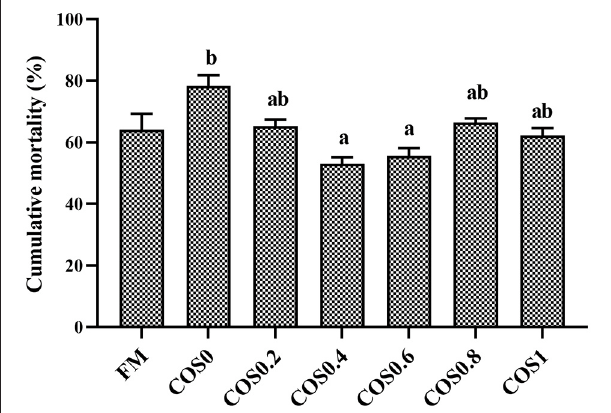
FIGURE 9 | Cumulative mortality of experimental hybrid grouper challenged with Vibrio harveyi for 7 days. Values are means ± SEM ( n = 3). Values in the same row with different superscript letters mean significantly different among COS-containing groups ( P <